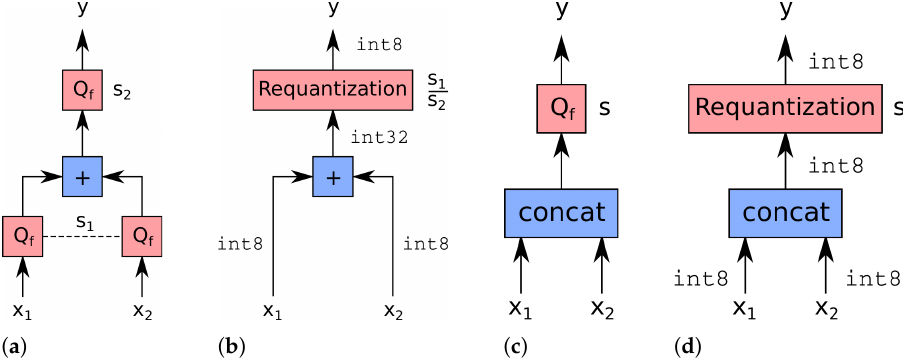
Figure 5. Fake quantized elementwise add ( a ), its implementation in hardware ( b ), fake quantized concat ( c ), and its implementation in hardware ( d ). The figures assume a uniform symmetric quantization scheme (only scale factors) for the sake of